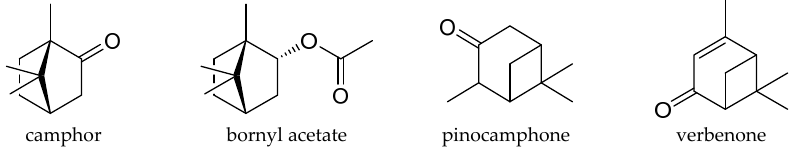
Figure 1. Major compounds of the essential oils of the Lamiaceae family.